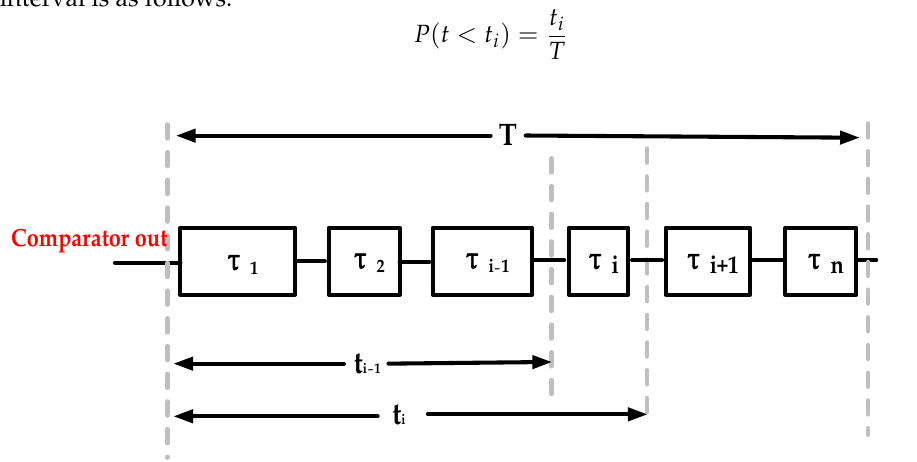
Figure 5. Block diagram of the code density test.